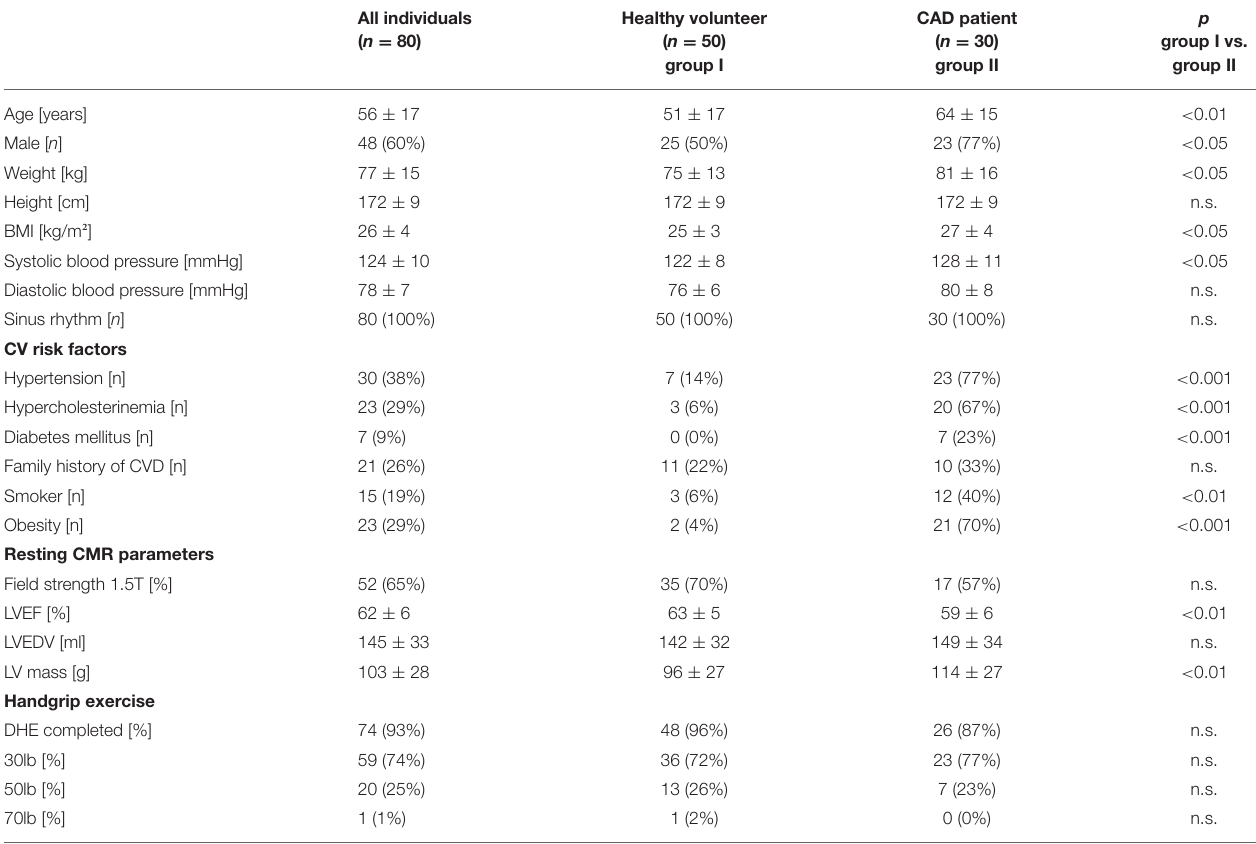
TABLE 1 | Baseline characteristics of all individuals ( n = 80) and divided by groups.